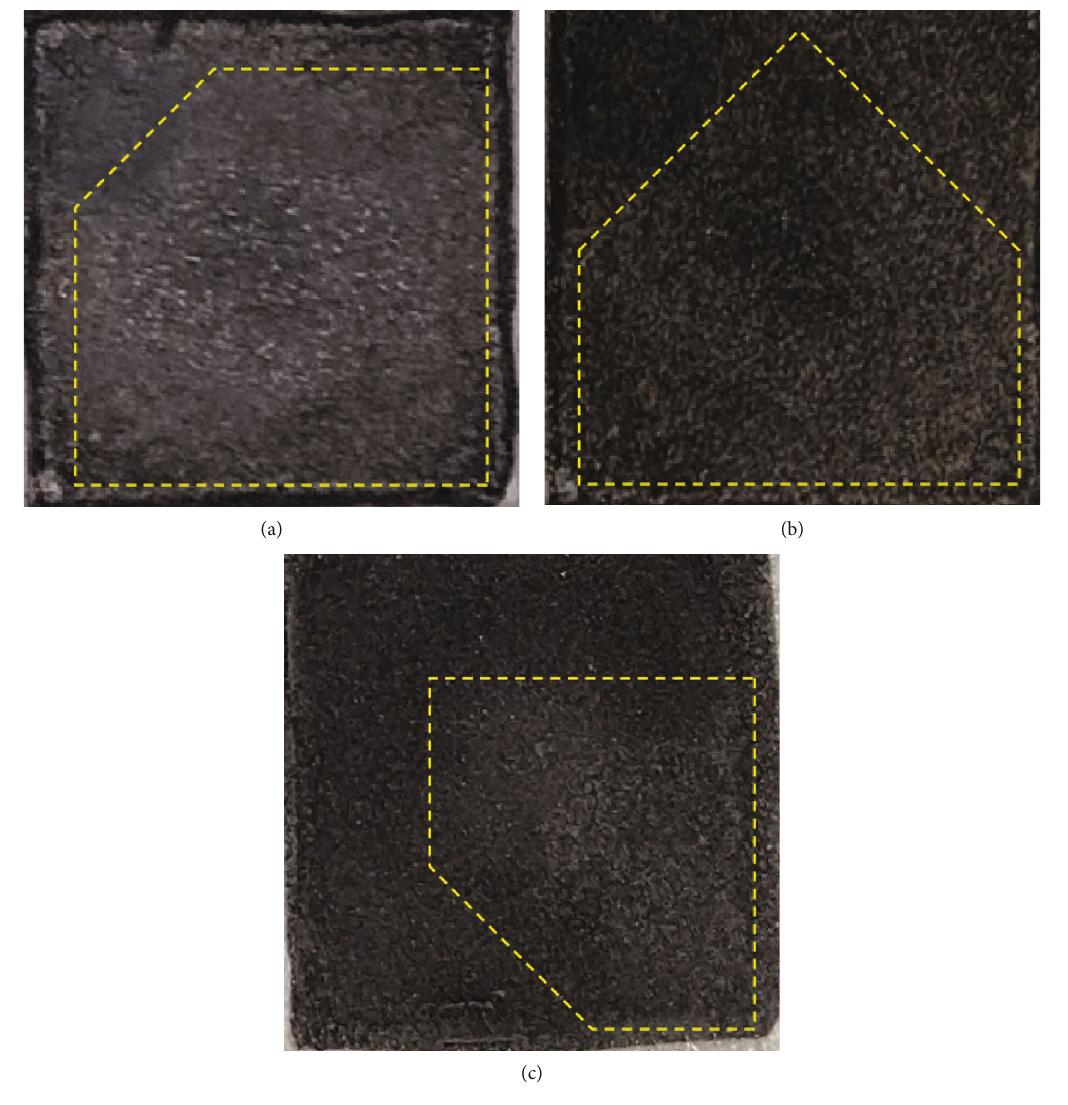
Figure 7: Frost on di ff erent surfaces. (a) C-2. (b) C-4. (c) C-6.